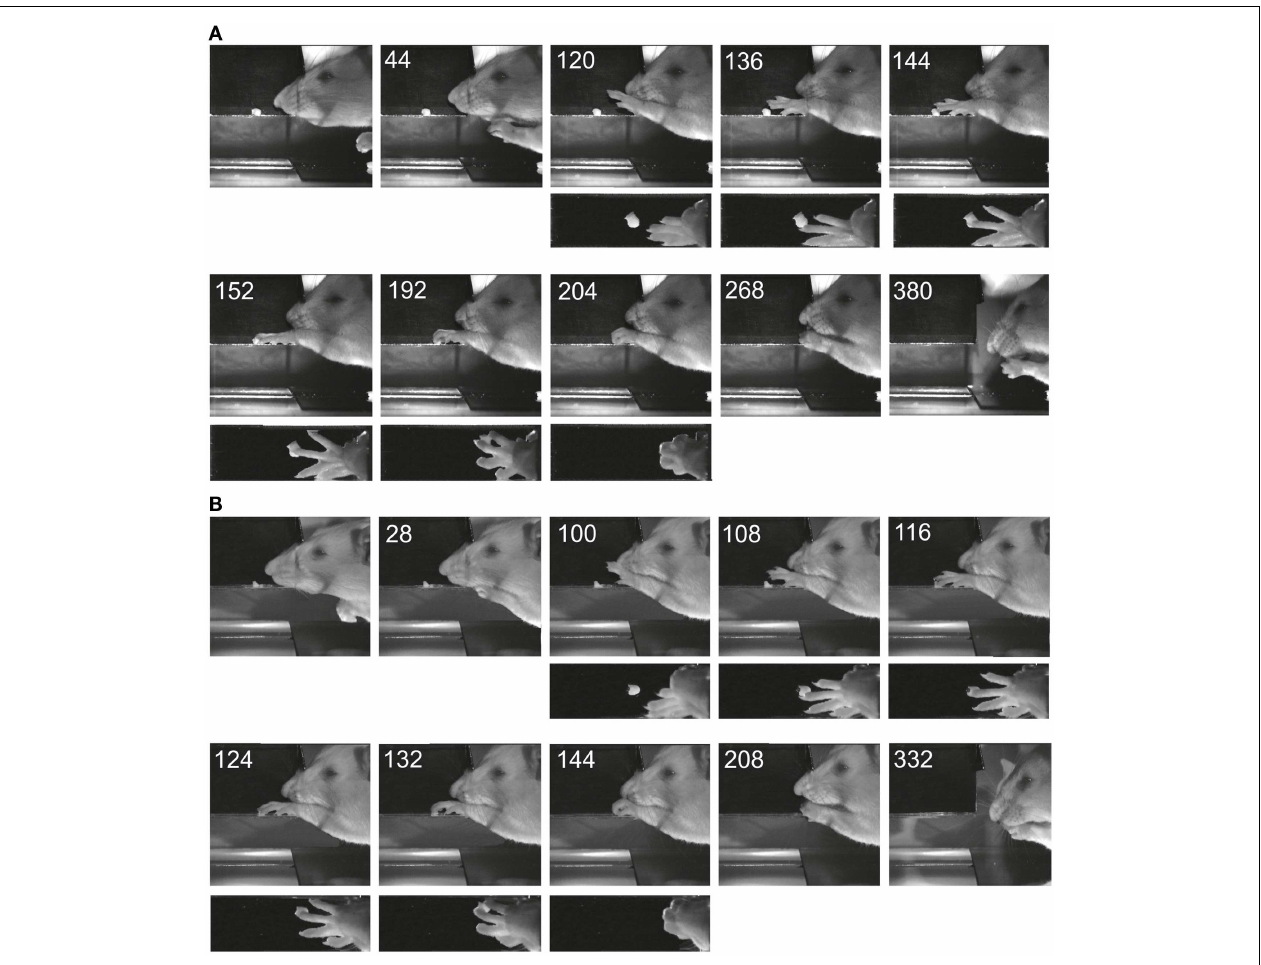
FIGURE 4 | Images of reaching and digit grasping movements obtained with high-speed video (250Hz) preoperatively (A) and 8days postoperatively (B) viewed from the lateral side and from above .Times are given in milliseconds relative to the first image.The background has been digitally